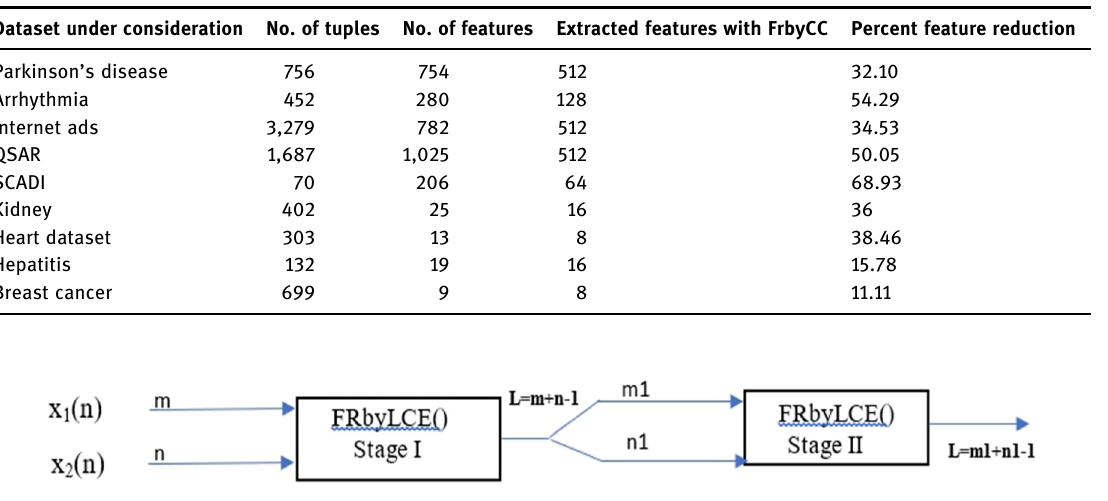
Table 3: Datasets under consideration and impact of FrbyCC method